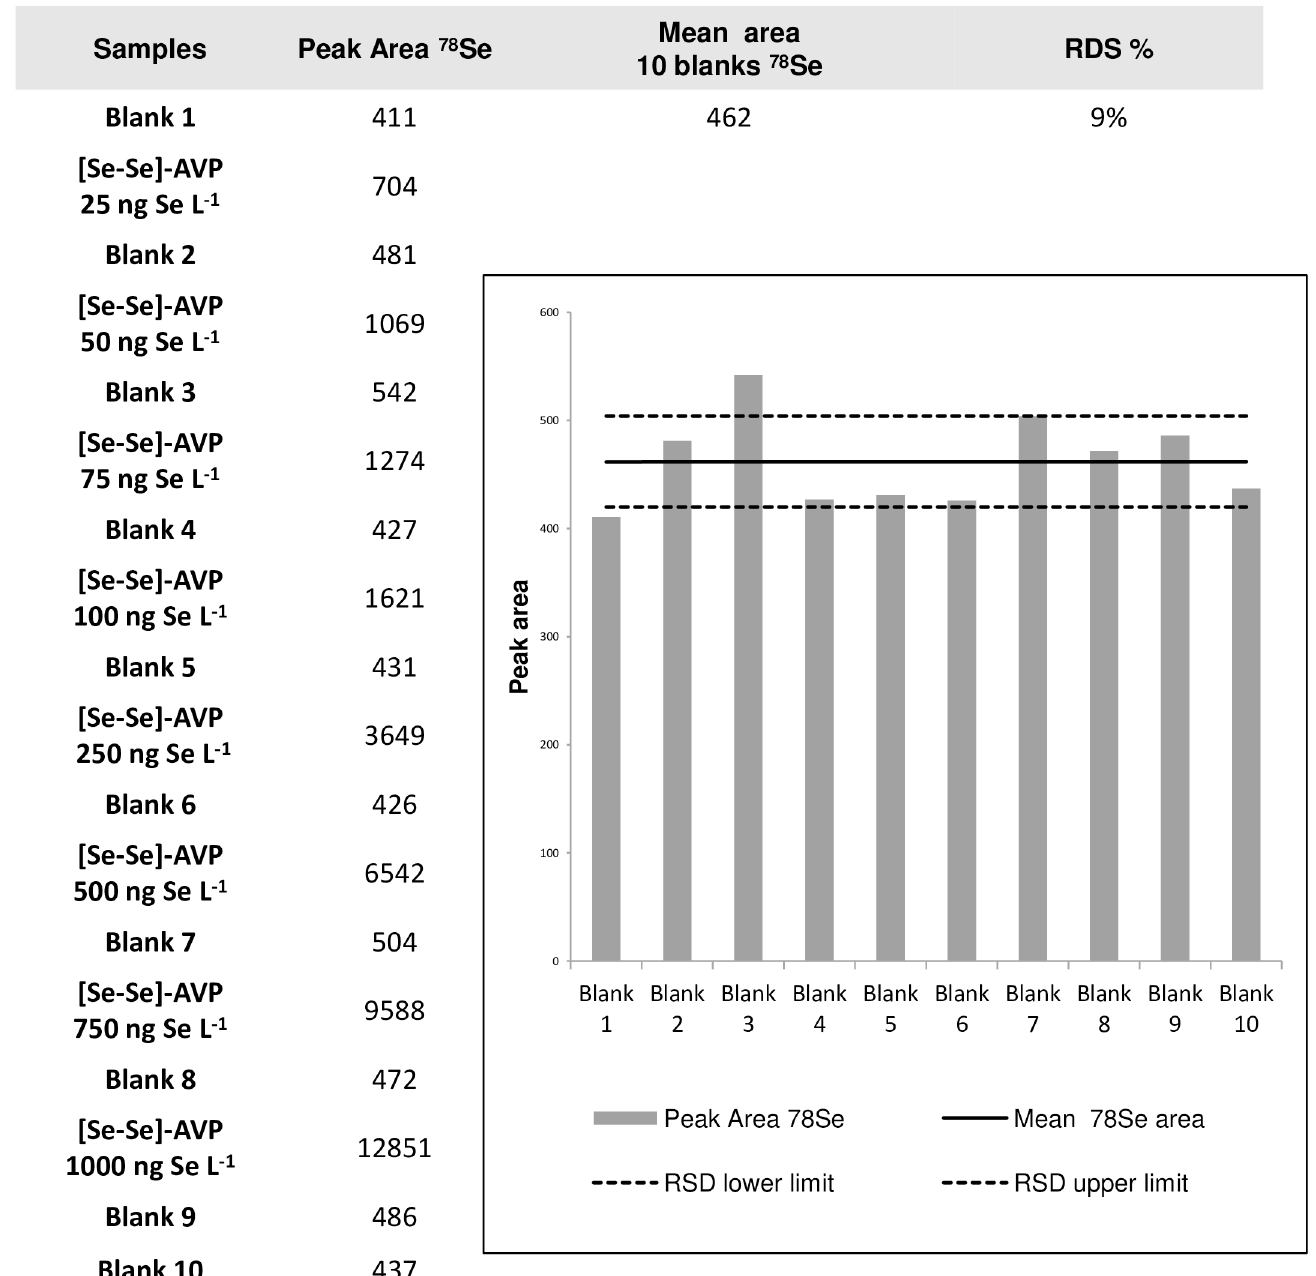
Fig 4. Injection of ten blanks with intercalated [Se-Se]-AVP peptide solutions at increasing